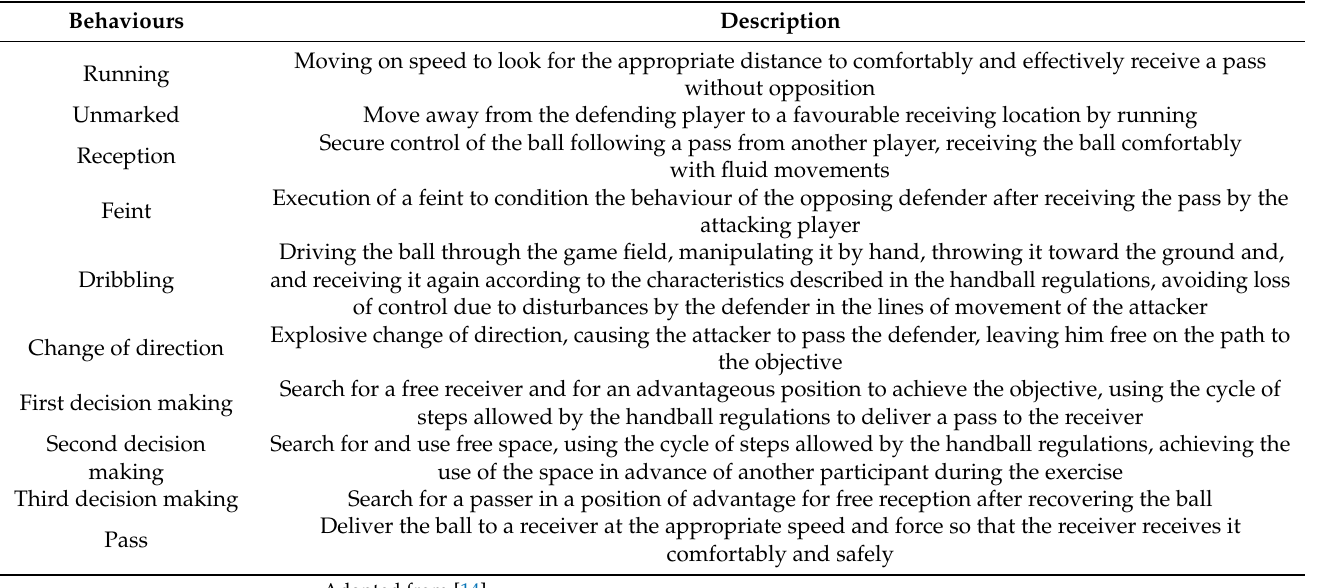
Table 1. Mini handball motor